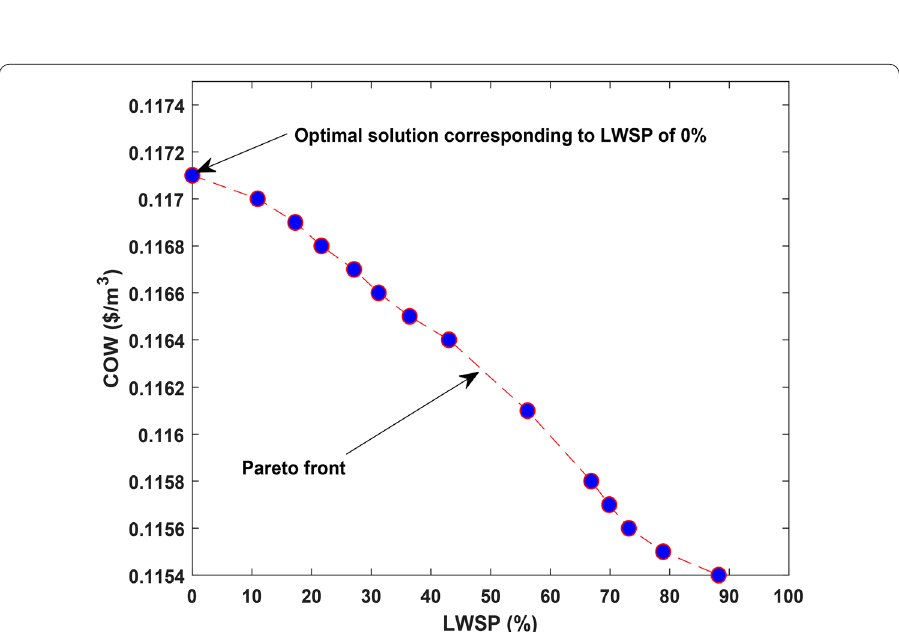
Fig. 6 Pareto front obtained for a double-objective